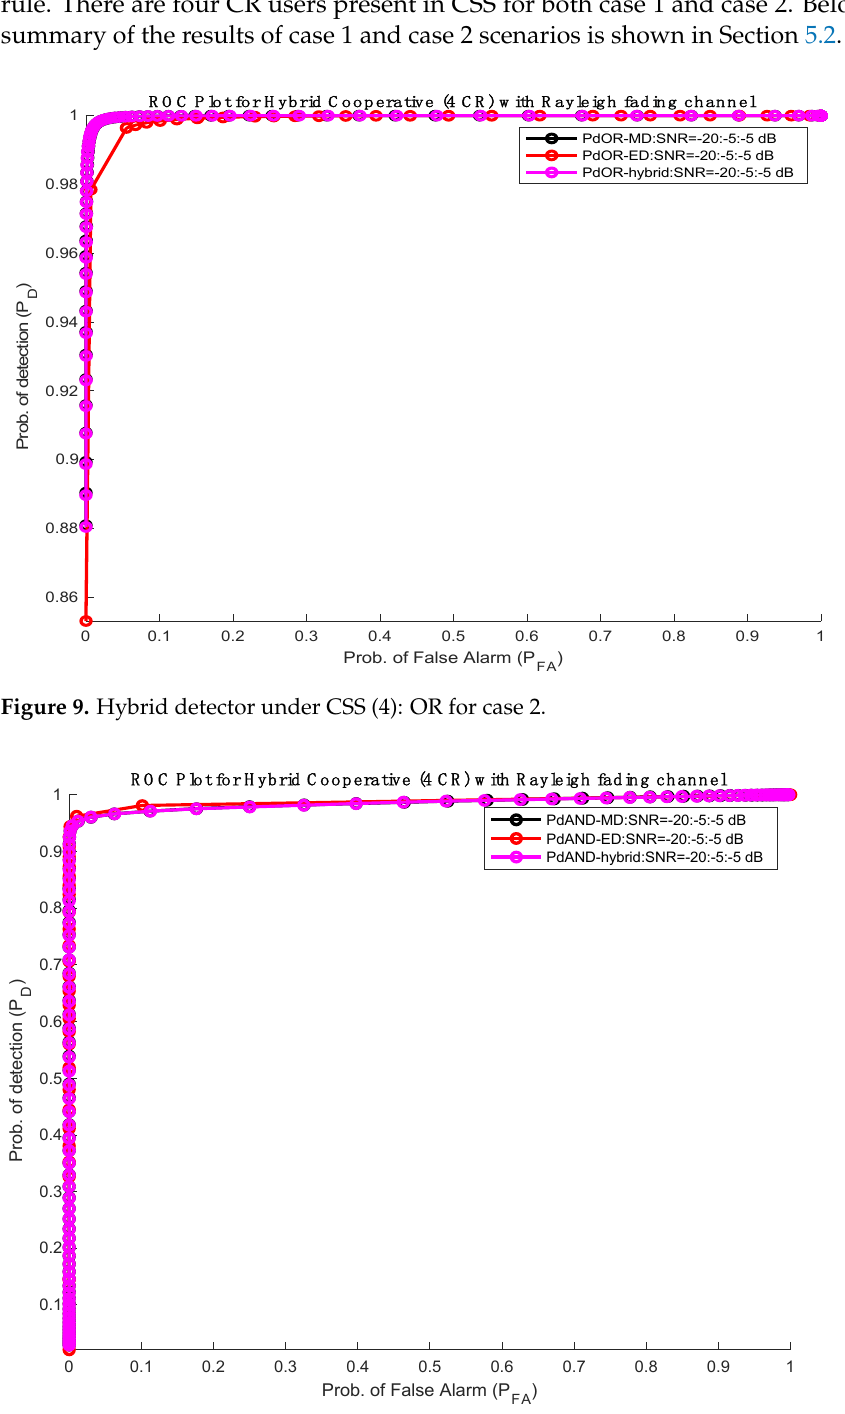
Figure 10. Hybrid detector under CSS (4): AND for case